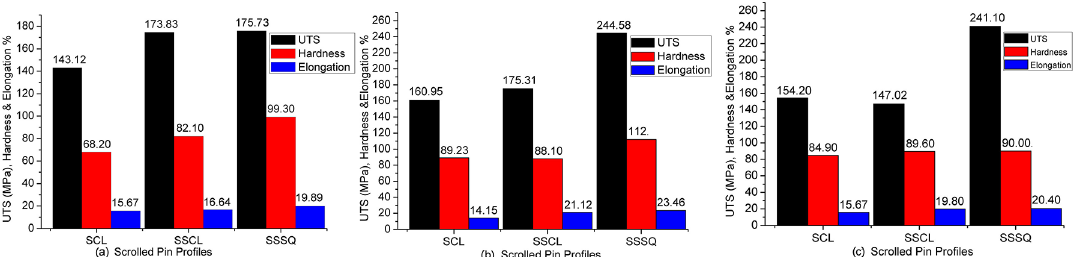
Figure 5. Mechanical properties of different scroll tool pin profiles at (a) 800 rpm (b) 1000 rpm (c) 1200 rpm